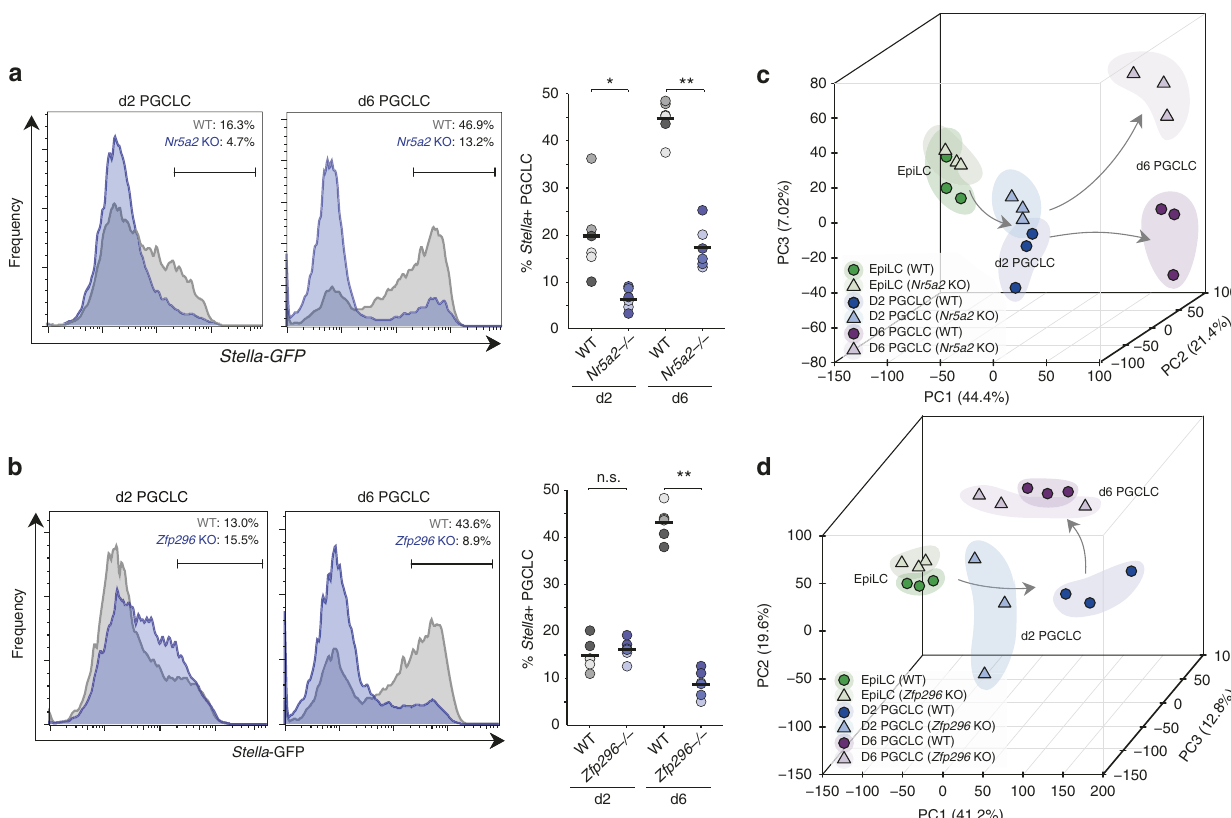
Fig. 4 Nr5a2 and Zfp296 are key regulators of germ cell development. a Representative FACS plot showing impaired induction of PGCLC in Nr5a2 -knockout (KO) cells. Shown right is replicate quanti fi cations of independent WT and KO lines. Independent lines are colour-matched. Bar indicates mean value. b Representative FACS of PGCLC in Zfp296 -knockout SGETs, with replicate quanti fi cation shown right. c Principal component analysis (PCA) showing the developmental trajectory of independent Nr5a2 − / − and matched-WT SGET lines during induction of PGCLC, based on global transcriptome. d PCA of independent Zfp296 − / − and matched-WT SGET transcriptomes. * p < 0.05; ** p <